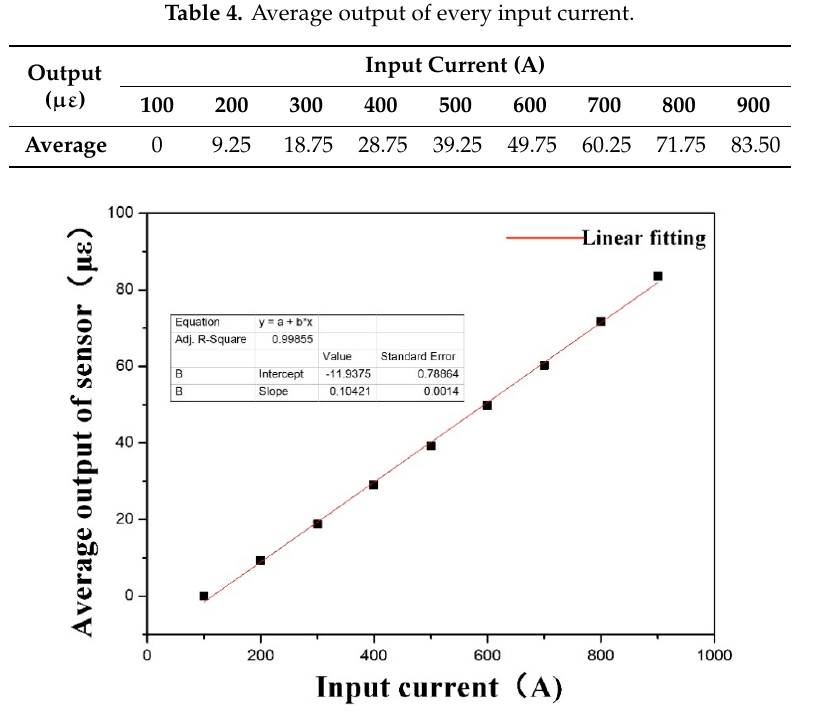
Figure 11. Repeatability test of sensor.